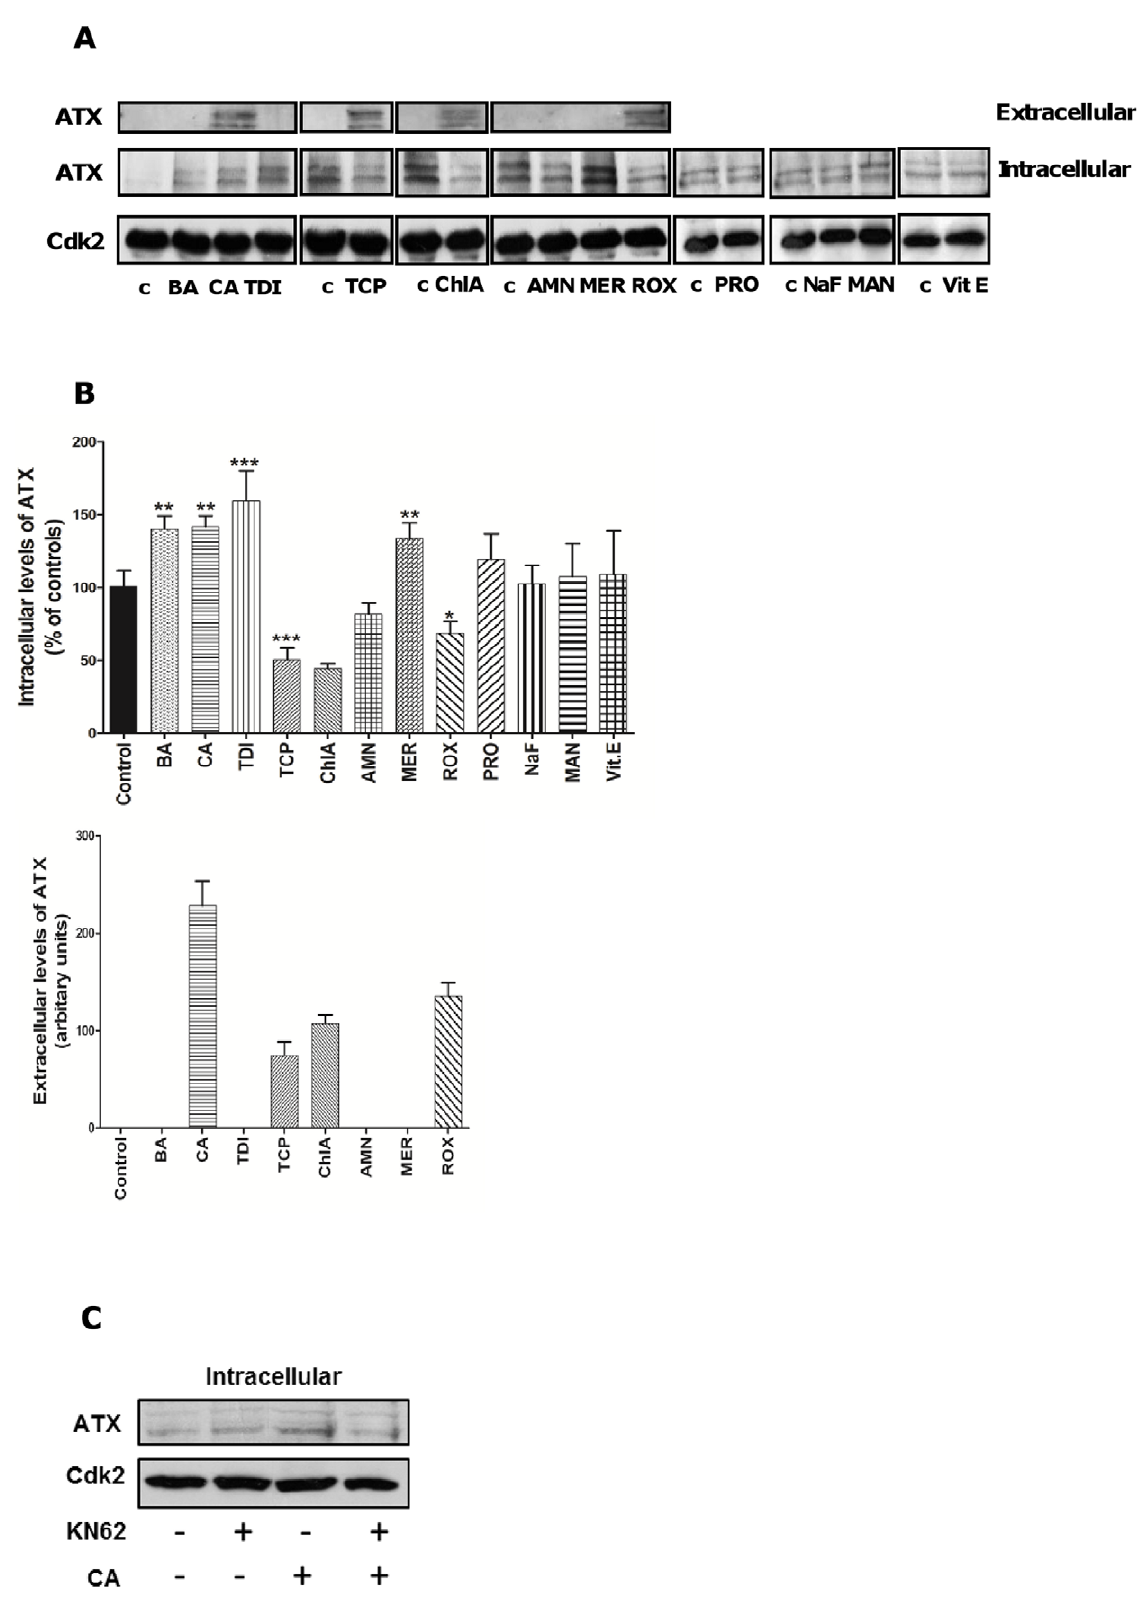
Figure 4. Male-specific pancreatic carcinogens induce ATX signaling in Panc-1. Cells were treated with 10 m M TCP, ChlA, BA, CA, TDI, AMN, MER, ROX, NaF, MAN, Vit E or PRO for 24 hours. ( A ) Representative Western blots of intracellular and extracellular ATX protein levels in Panc-1 cells. Different controls (c) were used (see Materials and Methods). ( B ) Densitometric analysis of intracellular and extracellular ATX levels in Panc-1 cells.